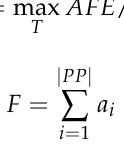
Table 4. Strategies used to configure the sets of A and P